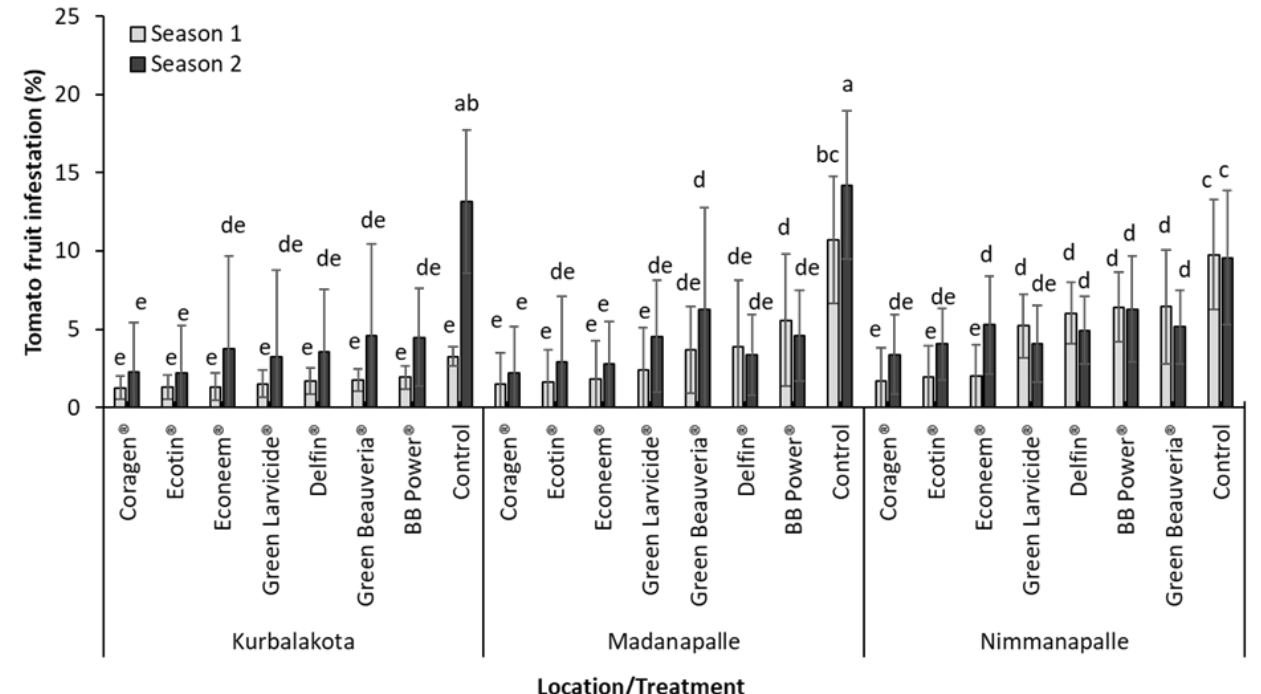
Figure 2. Mean ( ± SE) tomato fruit infestation percentage in three different locations of Andhra Pradesh, India and two growing seasons (May–August 2018, September–December 2018). Means represent average of ten replications for each treatment and three blocks ( n = 30). Beauveria bassiana -based formulations are as follows: Green Beauveria ® and BB Power ® ; Bacillus thuringiensis -based formulations are as follows: Green Larvicide ® and Delfin ® ; neem-based formulations are as follows: Econeem ® and Ecotin ® ; chemical pesticide is as follows: Coragen ® . Mean(s) followed by same letter(s) are not significantly different based on Tukey’s HSD ( p = 0.05).